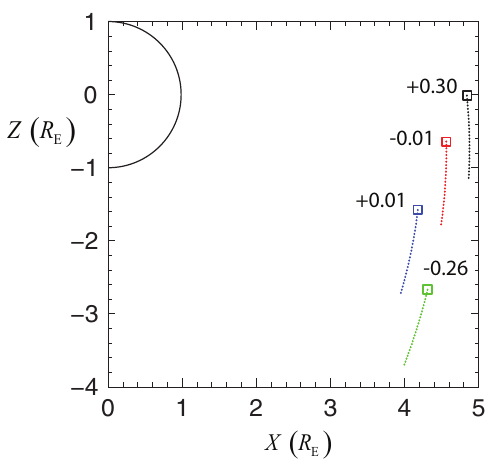
Fig. 1. CLUSTER spacecraft (where C1, C2, C3, and C4 are black, red, green, and blue, respectively) in a meridian with X = R cos ( MLAT ) and Z = R sin ( MLAT ) . The dotted tracks show the spacecraft orbits from 11:40UT to 12:07UT on 10 September 2002, and the position of the spacecraft at 12:07UT is indicated by the squares. The displacement in the out of plane (azimuthal) direc- tion at 12:07UT is indicated by the numerals next to the